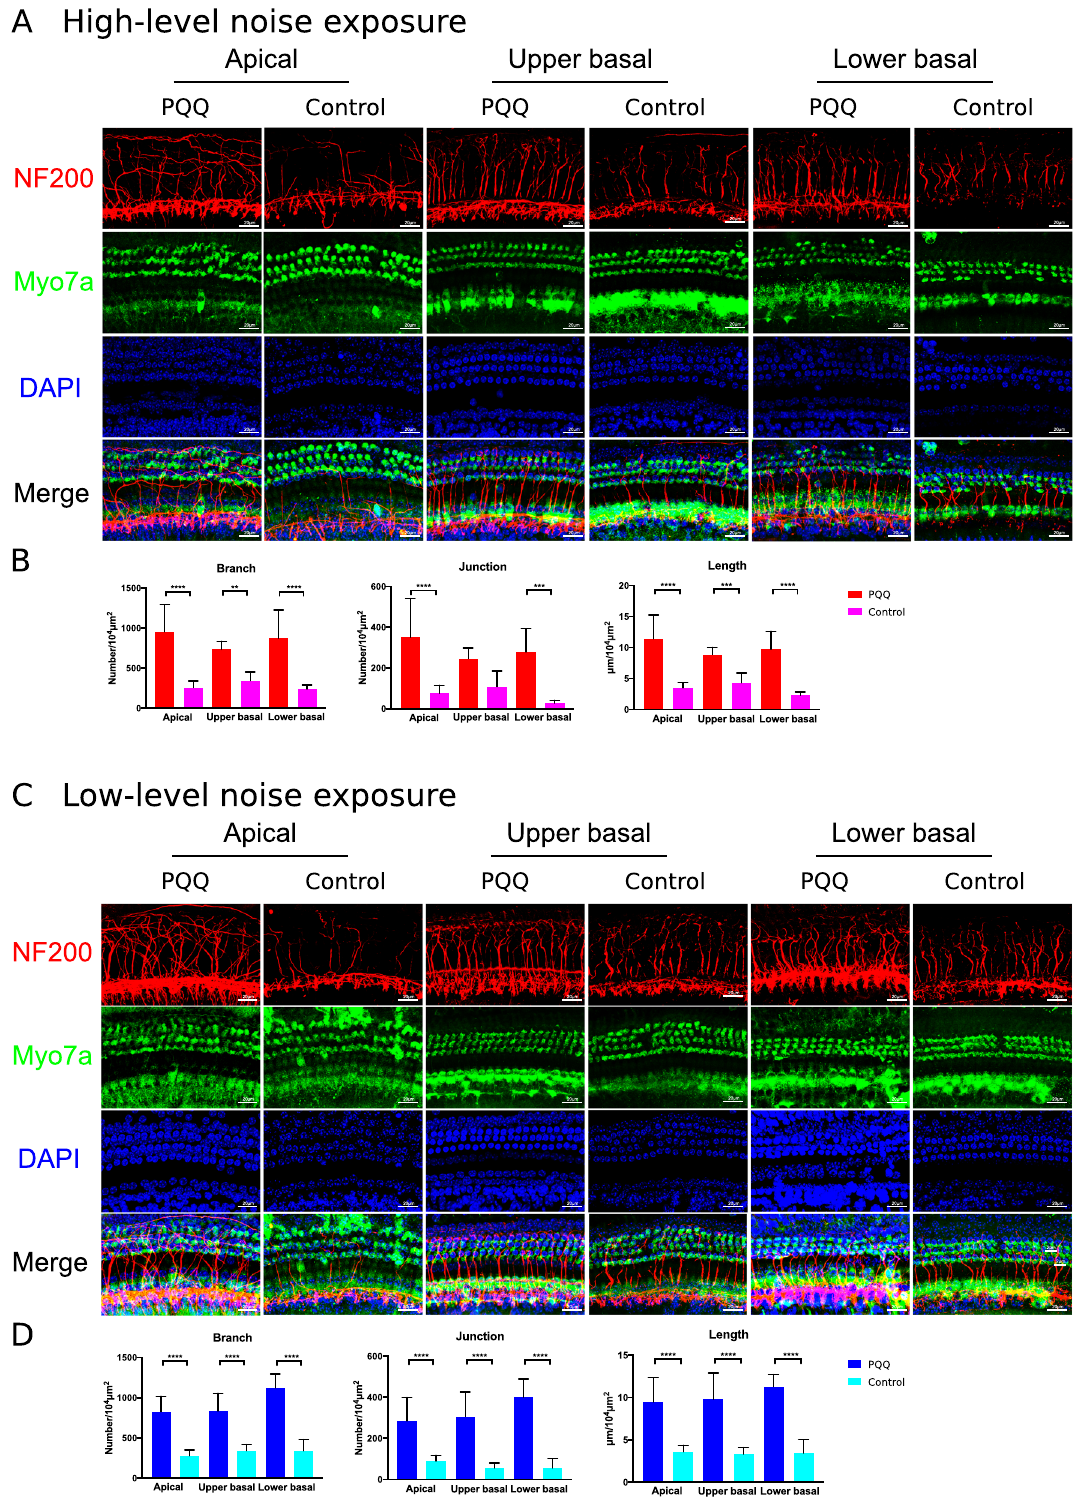
Figure 4. The evaluation of the spiral bundle of the spiral organ of Corti in the noise-induced hearing loss model ( A ) Confocal images of the spiral bundle of the spiral organ at the apical, upper basal and lower basal turns after high-level noise exposure. The hair cells were stained with anti-Myo7A (green), the peripheral axons of the spiral ganglion neurons with anti-NF200 (red), and the nuclei with DAPI (blue). Bar, 20 µm. ( B ) Quantitative analysis result of SGC peripheral axons with branches, junctions and lengths after high level noise exposure. The description of each parameter is in the methods section. ( C, D ) The spiral bundle of the spiral organ and the quantitative analysis of the bundles respectively after low-level noise exposure. ** p < 0.01, *** p < 0.001, **** p < 0.0001. ( n = 5 per